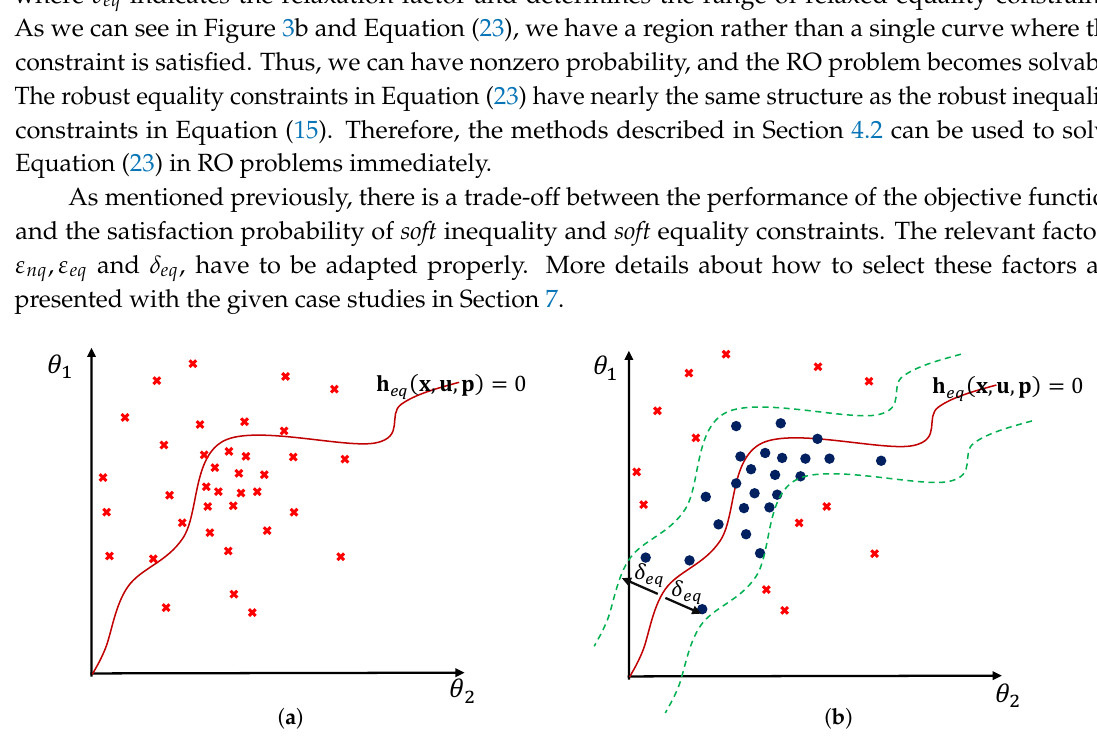
Figure 3. Illustration of soft equality constraints h eq ( x , u , p ) = 0. For the sake of explanation, a two-dimensional random space with uncertain parameters θ 1 and θ 2 is used. Samples satisfying the constraints are shown by blue-filled circles , while samples that violate the constraints are shown by red cross . ( a ) The probability of samples that satisfy the equality constraint (red line ) is equal to zero for the continuous random space; ( b ) the equality constraint and its relaxed boundaries (green dashed line ) with width δ eq . The probability of satisfying the equality constraints is given by the percentage of samples, i.e., , which are located within the